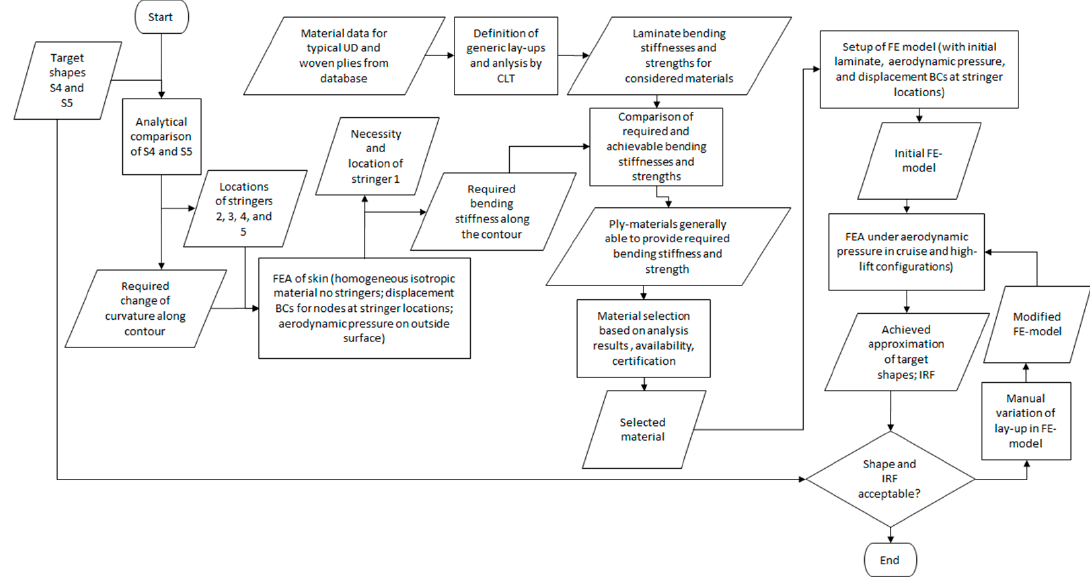
Figure 7. Simplified flow-chart of the process resulting in definition of the skin laminate.